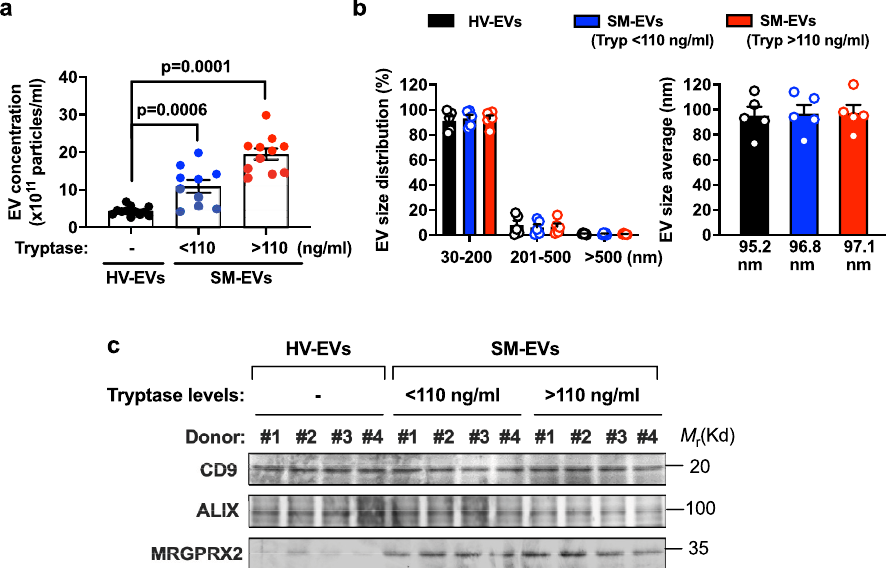
Fig. 1 Small extracellular vesicles are increased in the serum of patients with systemic mastocytosis. a Quantitative analysis of extracellular vesicles (EVs) isolated from individual serum samples of healthy volunteers (HV-EVs; black circles; n = 12 subjects), patients with systemic mastocytosis (SM) with tryptase values lower than the median (SM-EVs (Tryp < 110 ng/mL); blue circles; n = 10) or SM-EVs with tryptase values greater than the median (SM-EVs (Tryp > 110 ng/mL); red circles; n = 11) (see Group 1 of Supplementary Table 1 for patient population characteristics). EVs were counted and analyzed using a NanoSight NS300 system. Data represent the mean ± SEM. P values using a Mann – Whitney test (two-tailed) are indicated. b Size distribution (left) and average size (right) of HV-EVs and SM-EVs as determined by NanoSight. The bars represent fi ve independent measurements ( n = 5) of pooled HV-EVs from all subjects shown in a (black bars), pooled EVs from all patients with SM-EVs (Tryp < 110 ng/ml) (blue bars), and pooled EVs from all patients with (SM-EVs (Tryp > 110 ng/ml); red bars). Data represent the mean ± SEM. Similar results were obtained from at least three separate preparations of EV pools. c Western blots illustrating similar expression of EV markers such as CD9 and ALIX in EVs isolated from HV and patients with SM, and enriched expression of mast cell markers such as MRGPX2 in SM-EVs. Equal amounts of protein were loaded in all lanes. Similar results were obtained in at least two additional